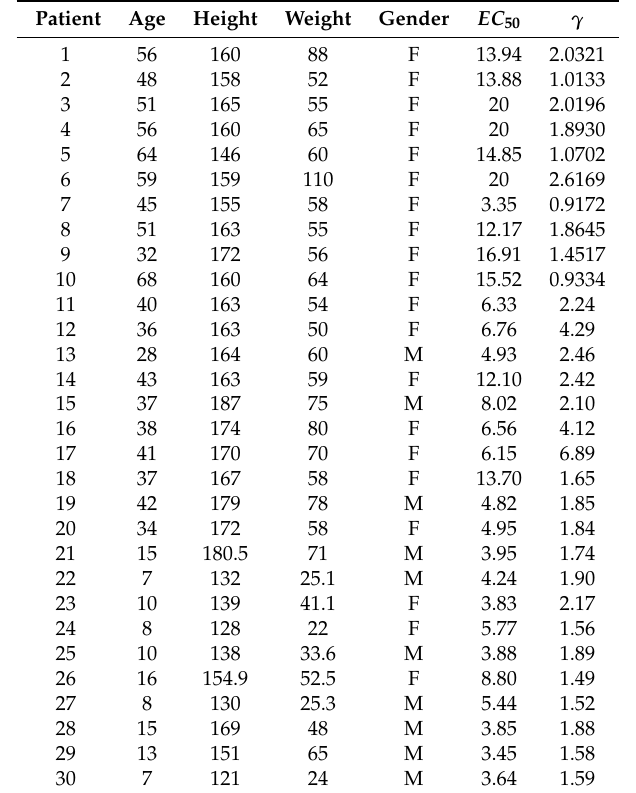
Table 1. Patients’ pharmacodynamic parameters and biometric